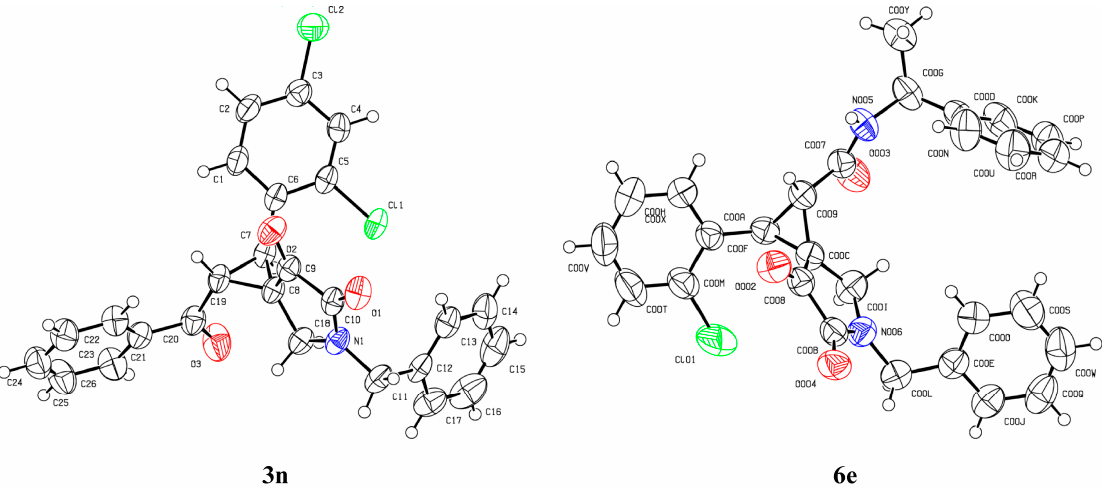
Figure 2 . Single crystal X-ray diffraction analysis of products 3n and 6e . Figure 2. Single crystal X-ray diffraction analysis of products 3n and 6e